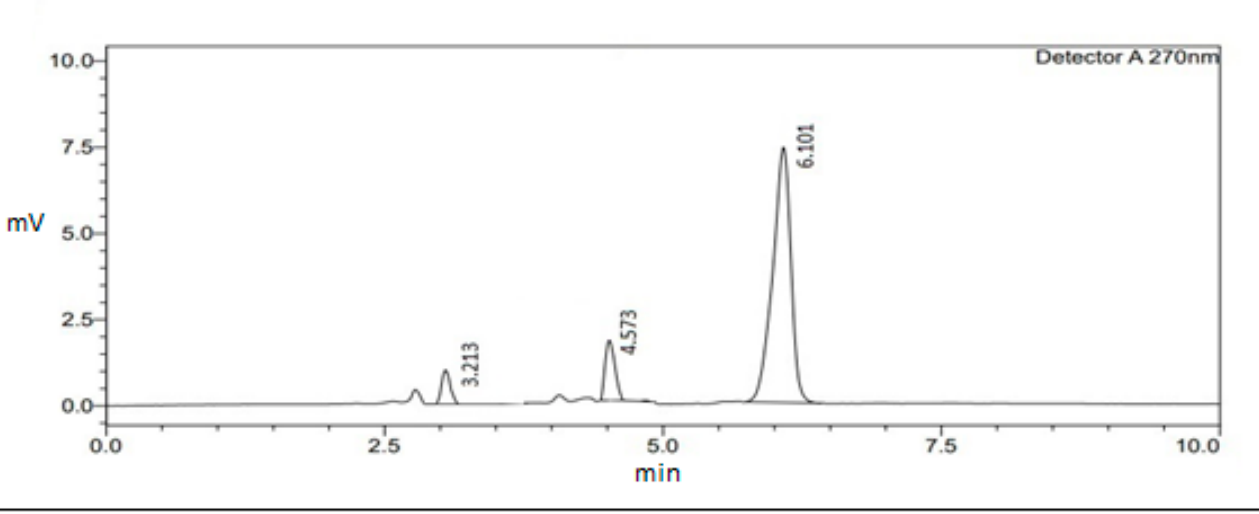
Figure 1. Reverse-phase high-performance liquid chromatography (RP-HPLC) chromatogram of DOM and CIN in plasma at LLOQ concentration with IRB as internal standard.